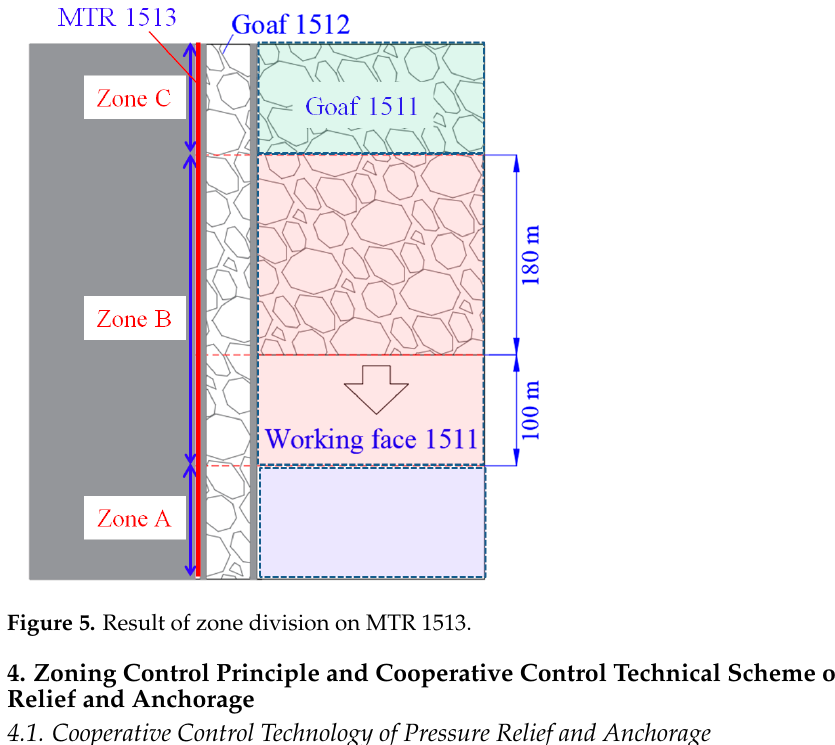
Figure 6. Collaborative control technology of pressure relief and anchorage.